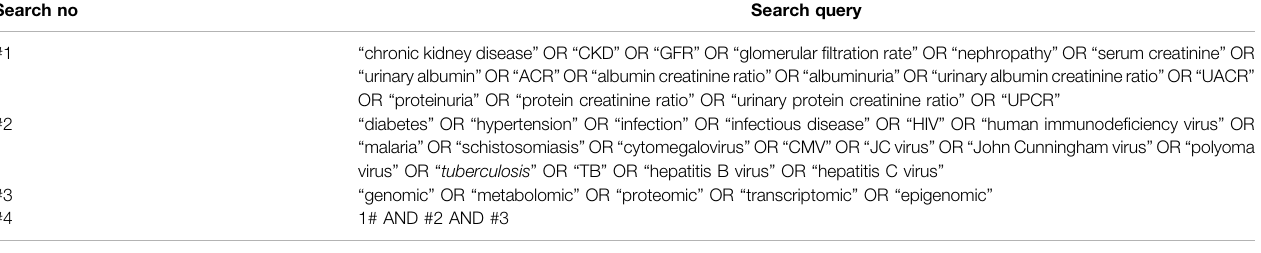
TABLE 1 | Search strategy used in database searches.